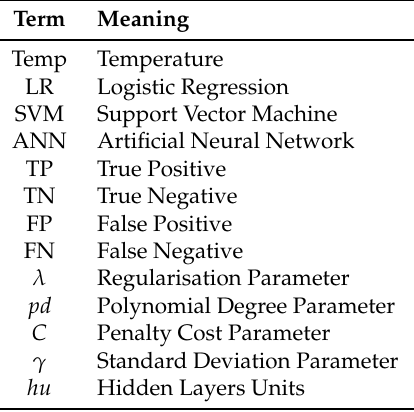
Table 1. Notation